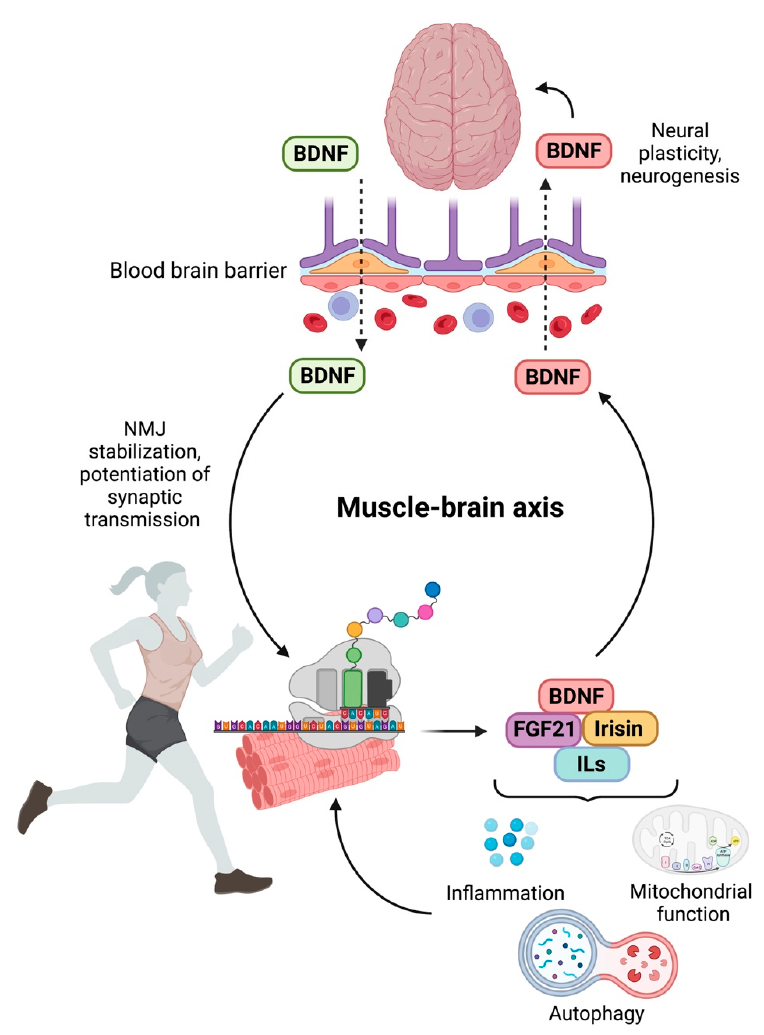
Figure 2. Schematic representation of the muscle–brain axis. Abbreviations: BDNF, brain-derived neurotrophic factor; FGF21, fibroblast growth factor 21; ILs, interleukins; NMJ, neuromuscular junction. Created with BioRender.com, accessed on 14 March 2023.